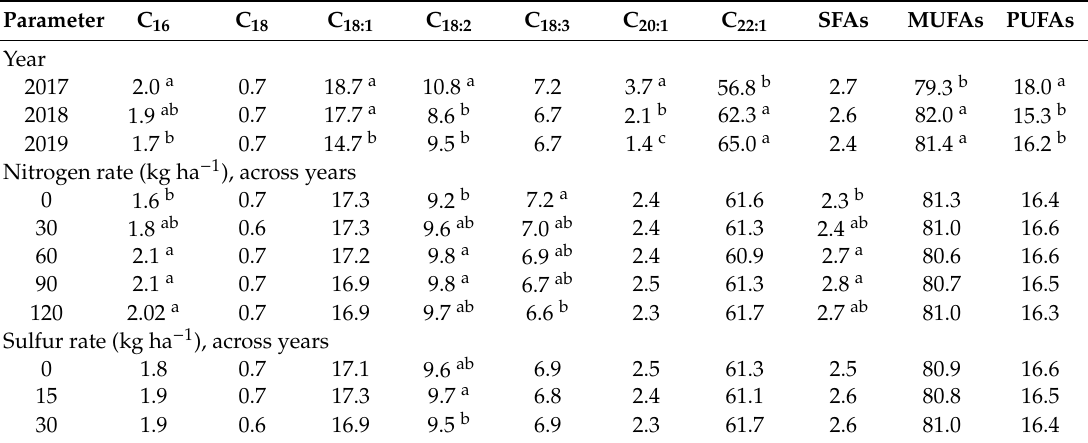
Table 6. Fatty acid composition of crambe oil